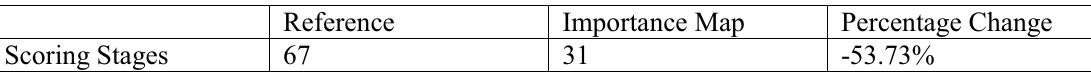
Table II.: Comparison of Number of Scoring Stages before reaching a required standard deviation for all fissile regions before and after the inclusion of an importance